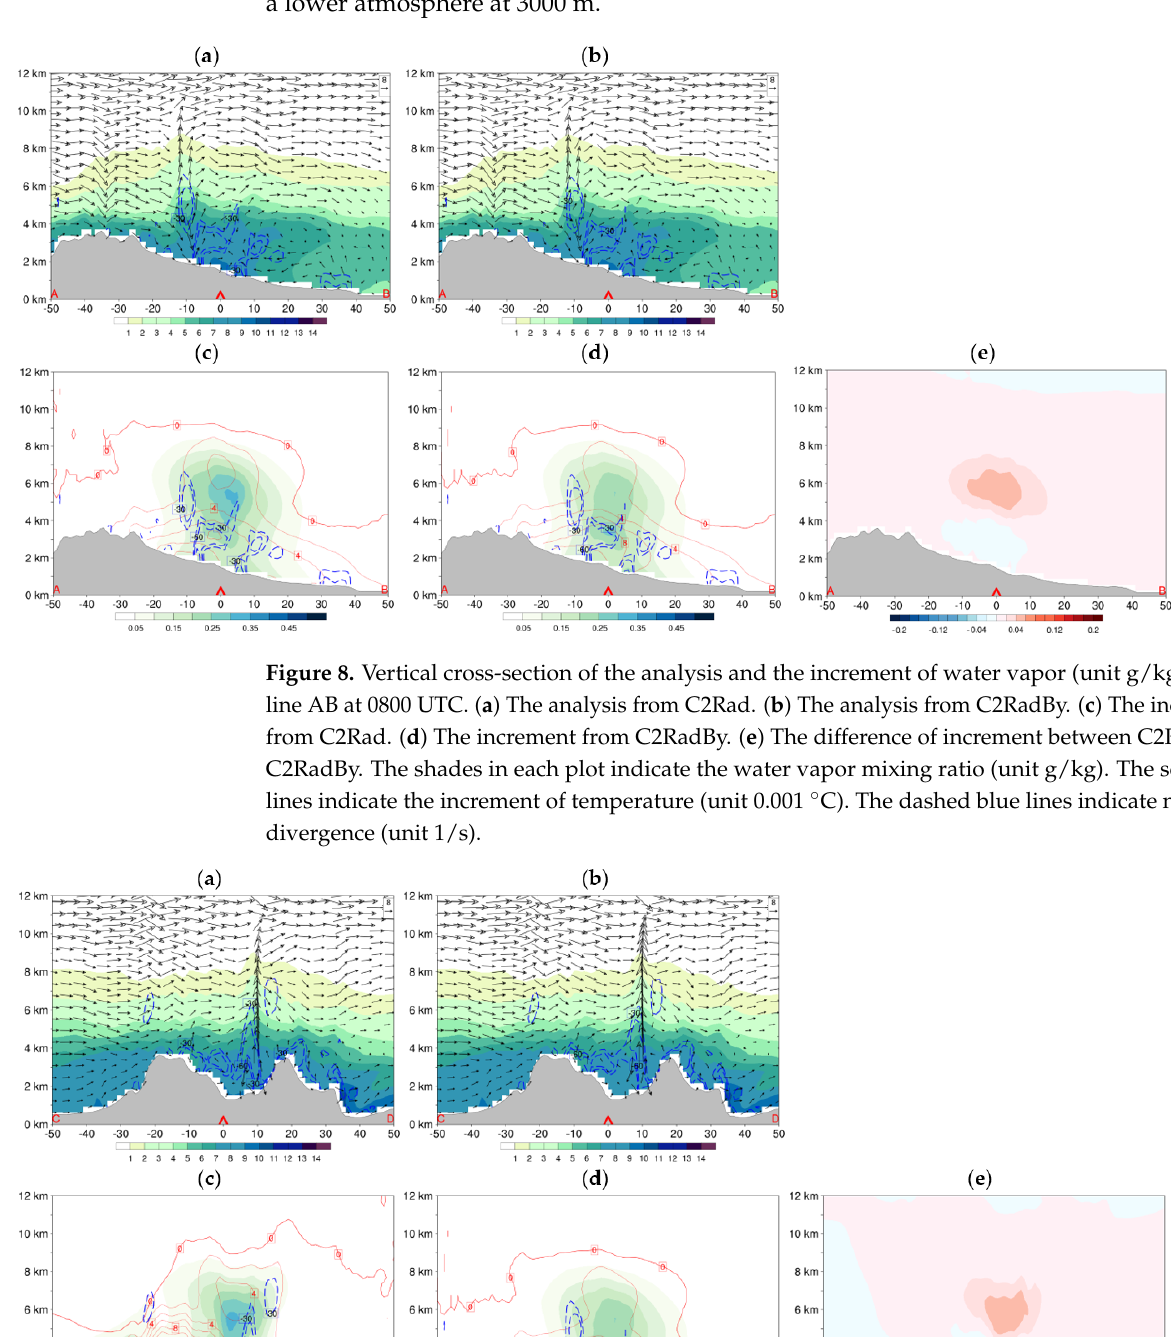
Figure 10. Horizontal cross-section of the analysis and the increment of water vapor (unit g/kg) at 0800 UTC at 3000m. ( a ) The analysis from C2Rad. ( b ) The analysis from C2RadBy. ( c ) The increment from C2Rad. ( d ) The increment from C2RadBy. ( e ) The difference of increment between C2Rad and C2RadBy. The shades in each plot indicate the water vapor mixing ratio (unit g/kg). The solid red